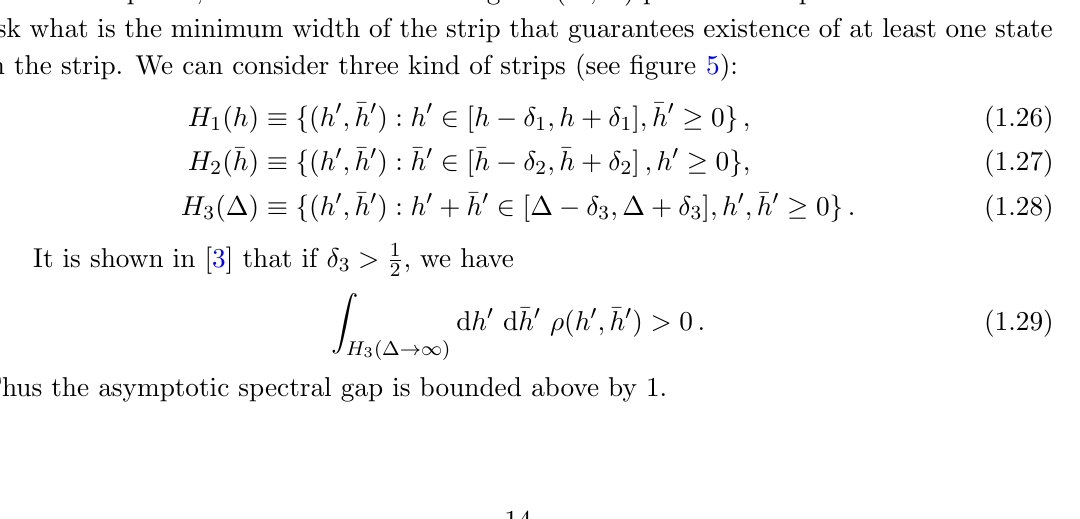
JHEP01(2020)135